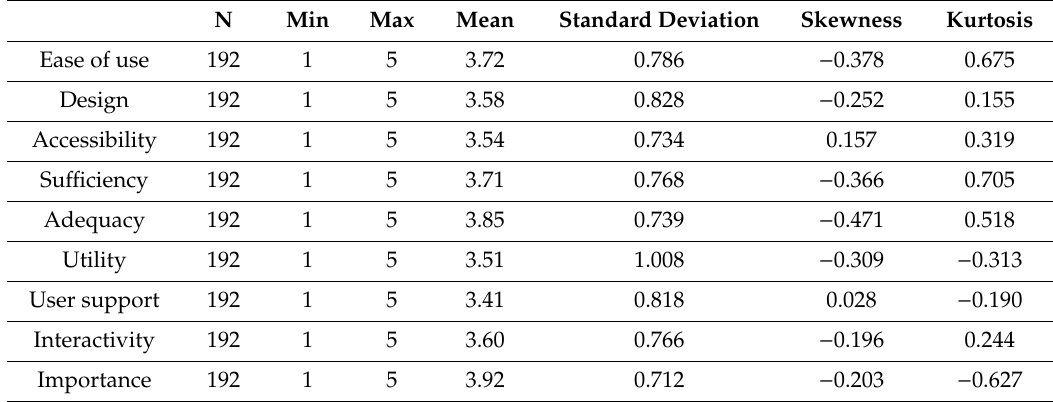
Table 3. Result of the descriptive